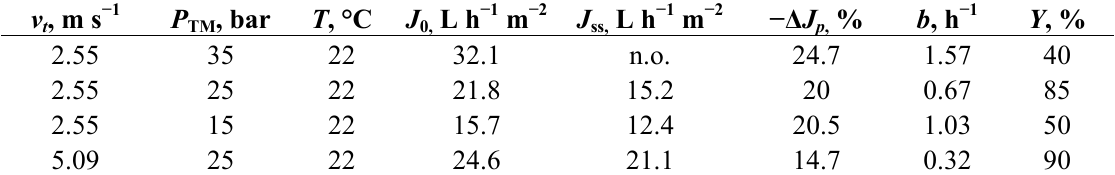
Table 5. Results determined for the RO performance at several operating